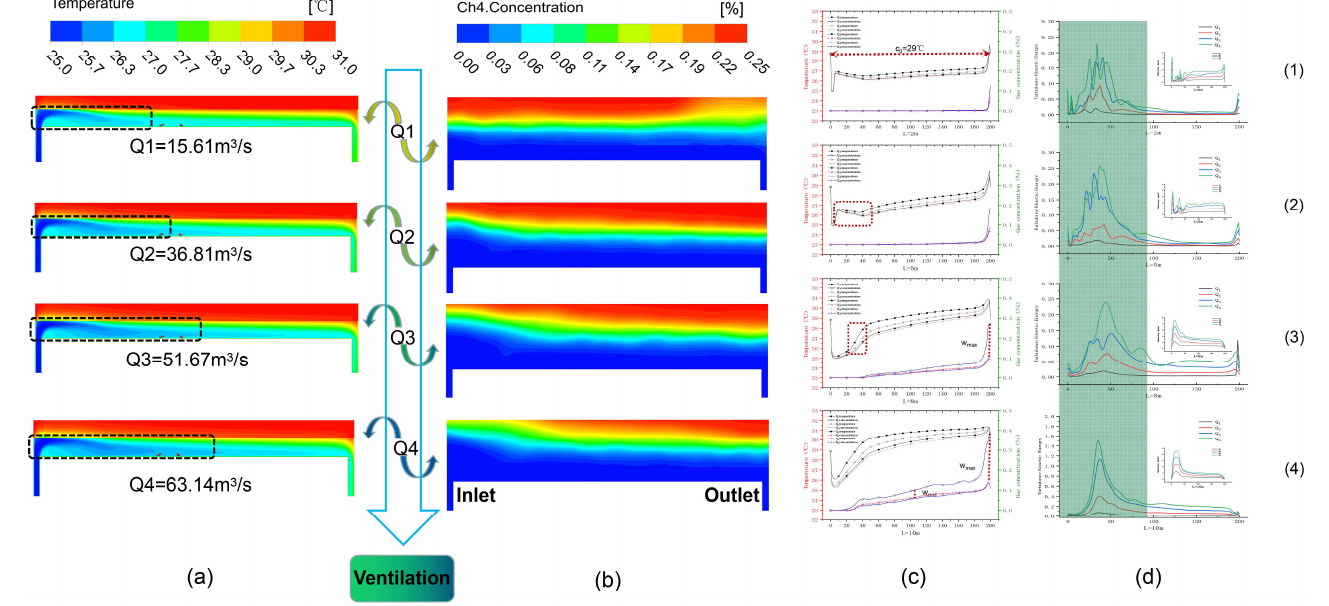
Figure 8. Temperature and gas concentration distribution diagram and data curve of different air volumes. ( a ) temperature distribution map; ( b ) gas concentration distribution map; ( c ) temperature and gas concentration curve; ( d ) turbulent kinetic energy and velocity curve; (1) L = 2; (2) L = 5; (3) L = 8; (4) L = 10.